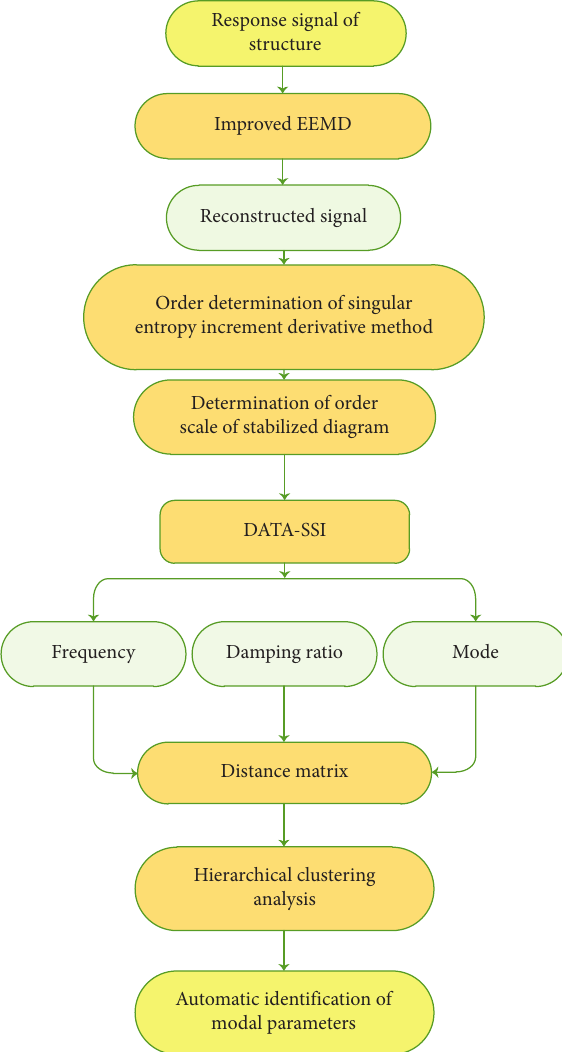
Figure 3: Flowchart of the automatic identification of modal